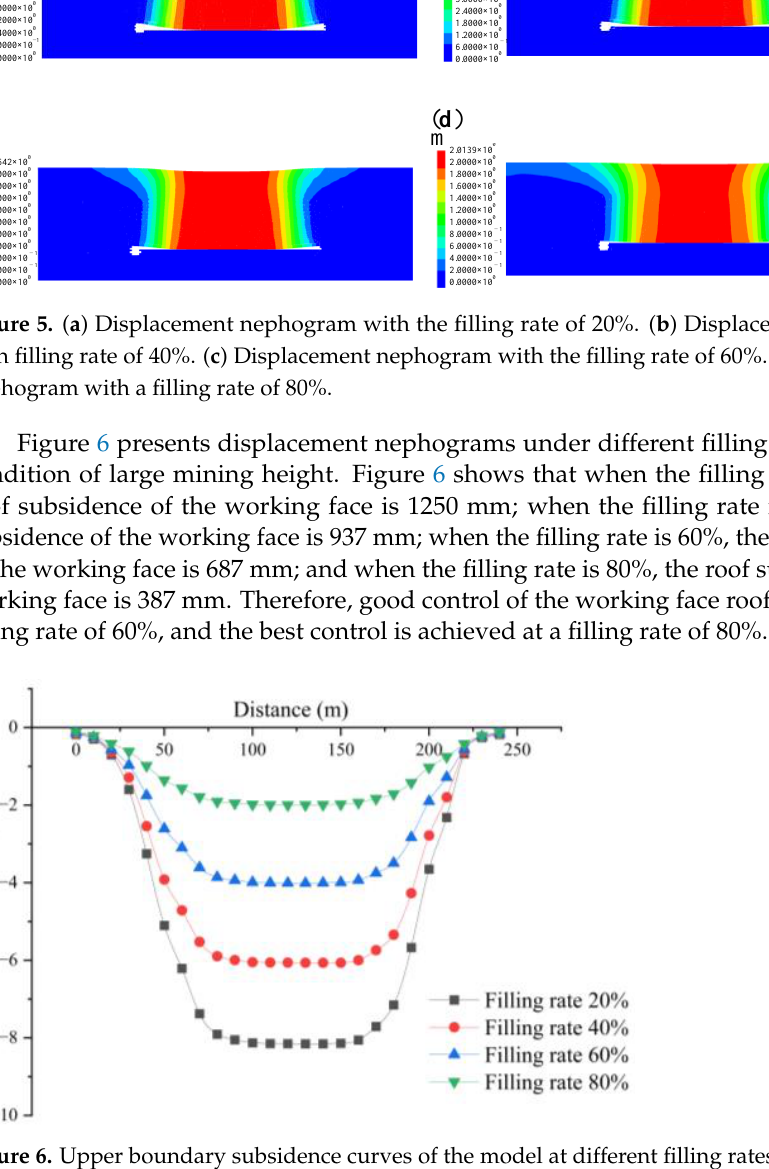
Figure 6. Upper boundary subsidence curves of the model at different filling rates.